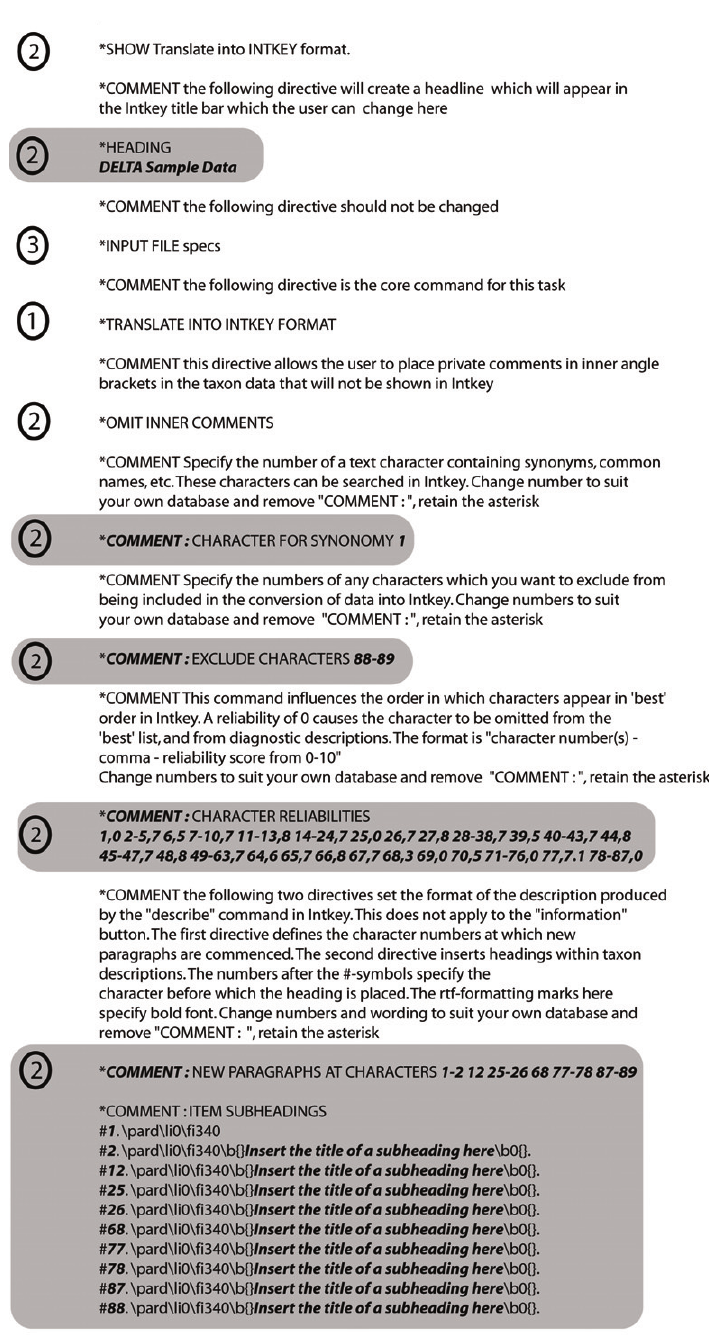
Figure 30. Directive fi le toint for generating the fi les needed for Intkey. Th e numbers to the left of the directive fi le indicate diff erent classes of directives (see Table 3). Th e grey ovals show commands where input of the user might be required. (continued on next